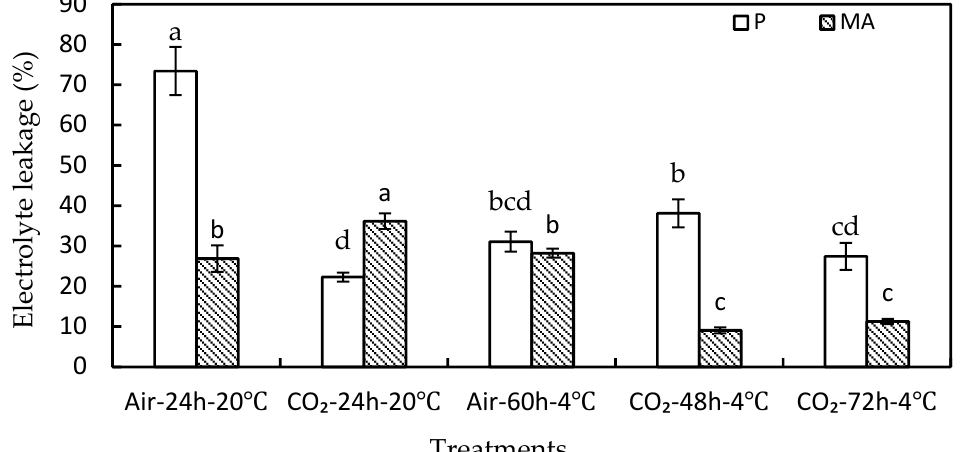
Figure 2. Electrolyte leakage of green asparagus treated with 60% CO 2 and air on the final storage day in P and MA packages. All groups were stored at 4 °C until the final day. Values are presented as means ± SE ( n = 5). Different letters among the same packaging types indicate statistical difference using an LSD (Least Significant Difference) test at p < 0.05.